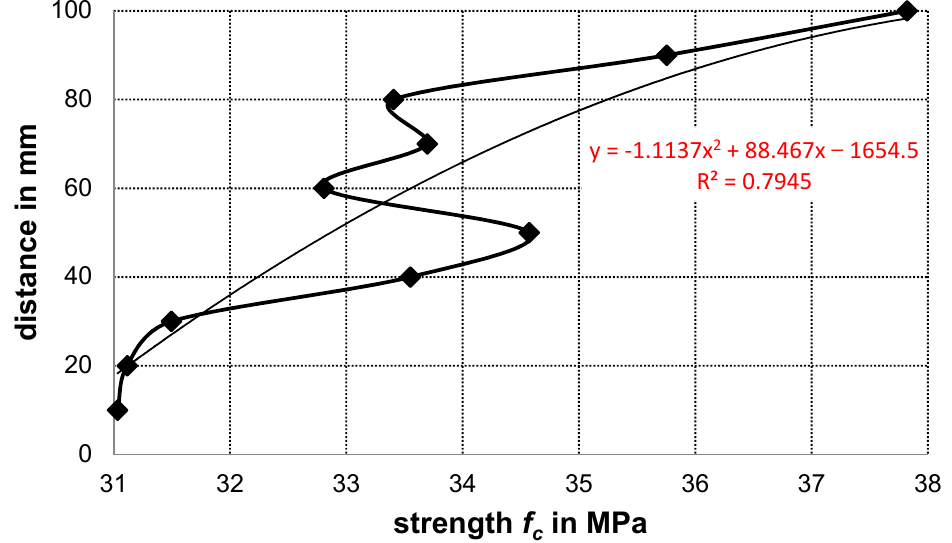
Figure 11. Compressive strength distribution in the sample taken from the slab loaded with the fire for a short period (sample no. 007).